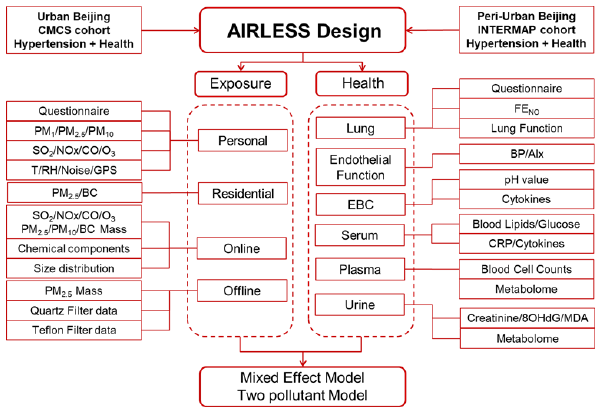
Figure 1. Design scheme of